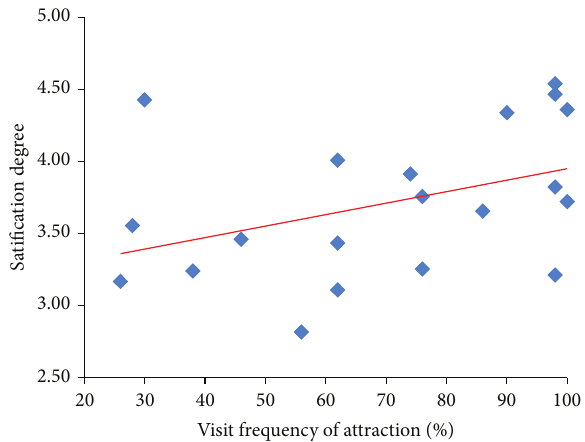
Figure 8: Visit frequency of attraction and satisfaction degree.